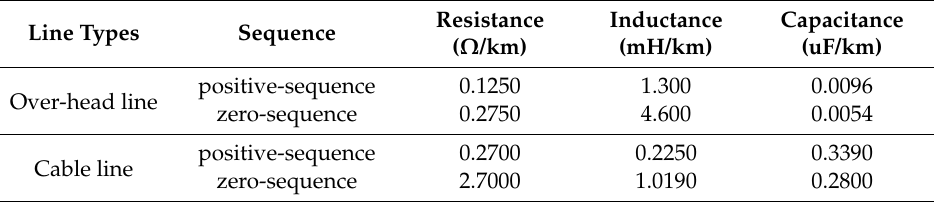
Figure 5. Simulation model of RGDN. Table 1. The parameters per kilometre for the lines.